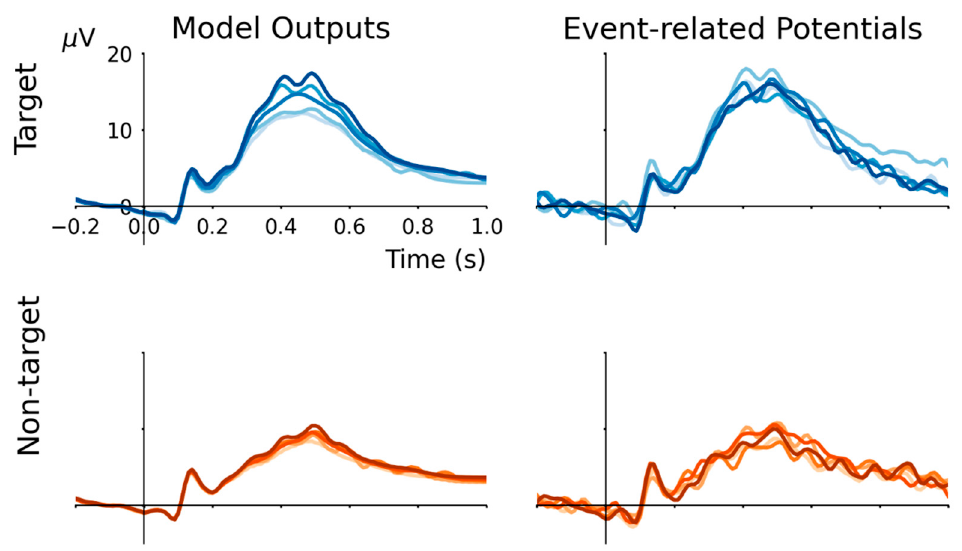
Figure 2. In five-fold cross-validation, model outputs strongly correlate with held-out validation ERPs. Target events AA, BB, CC, DD and EE paired with non-target events EB, AC, BD, CE and DA were held-out in turn to compute validation ERP waveforms that were compared with model outputs. Because the trained RNN produces output that approximates the grand-average ERP from each input condition, and the ERP evoked by an individual event does not deviate substantially from the grand-average of its event-type (i.e., target or non-target), the model outputs are highly correlated with held-out ERPs (all r 2 > 0.95).